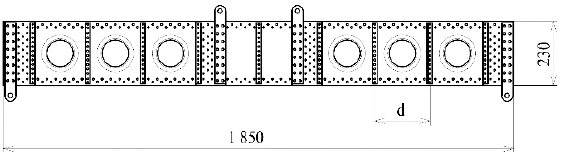
Fig. 1. Scheme of a specimen